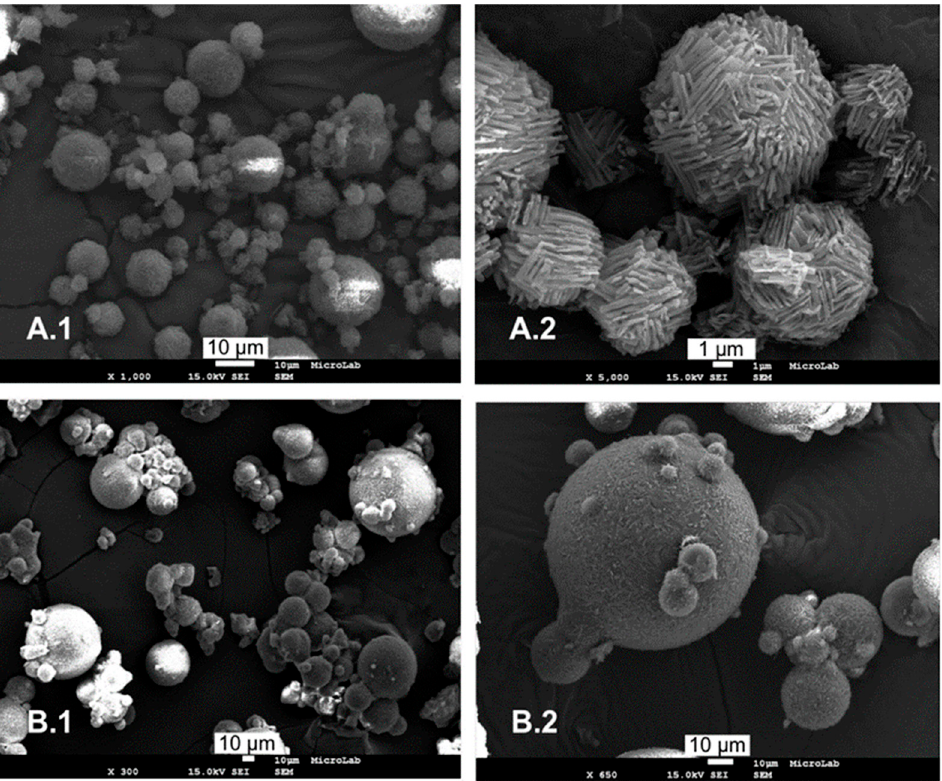
Figure 8. Micrographs correspondent to the cocrystals obtained by spray congealing with caffeine ( A ) and carbamazepine ( B ). Reprinted with permission from [92].